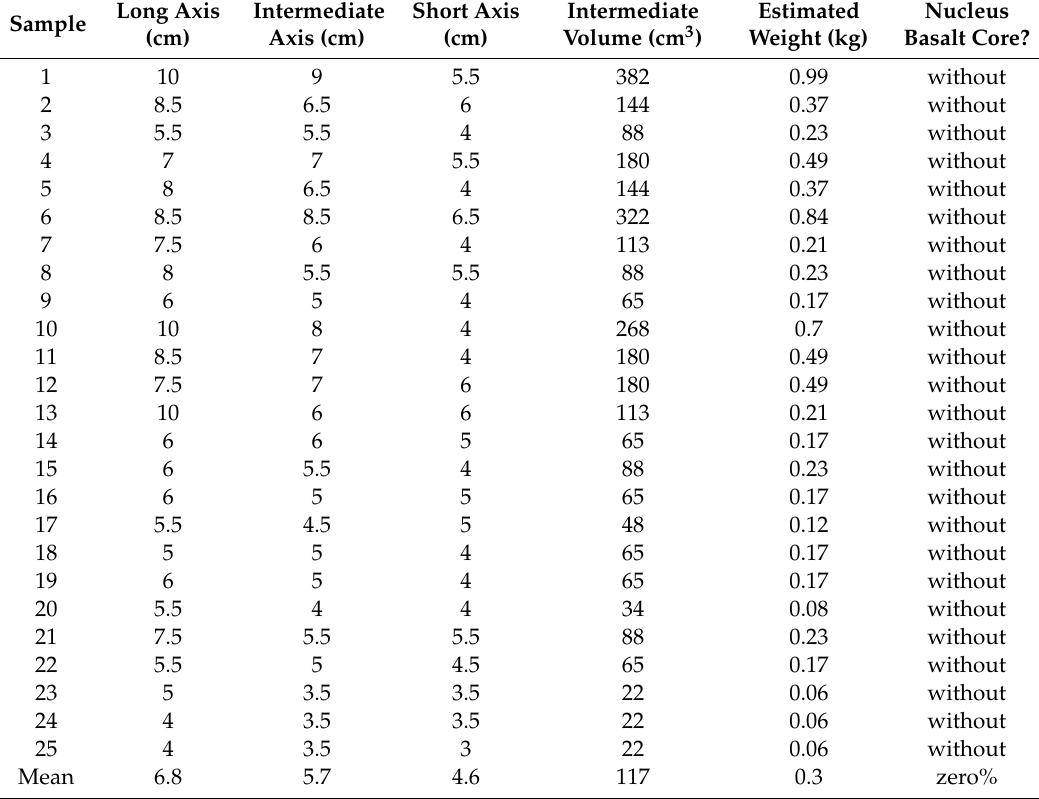
Table A2. Quantification of rhodolith size, volume, and estimated weight from the Holocene deposit at Ba í a das Gatas. The density magnesium-rich limestone at 2.6 gm / cm 3 is applied uniformly in order to estimate the weight of each sample based on the radius measured against the intermediate